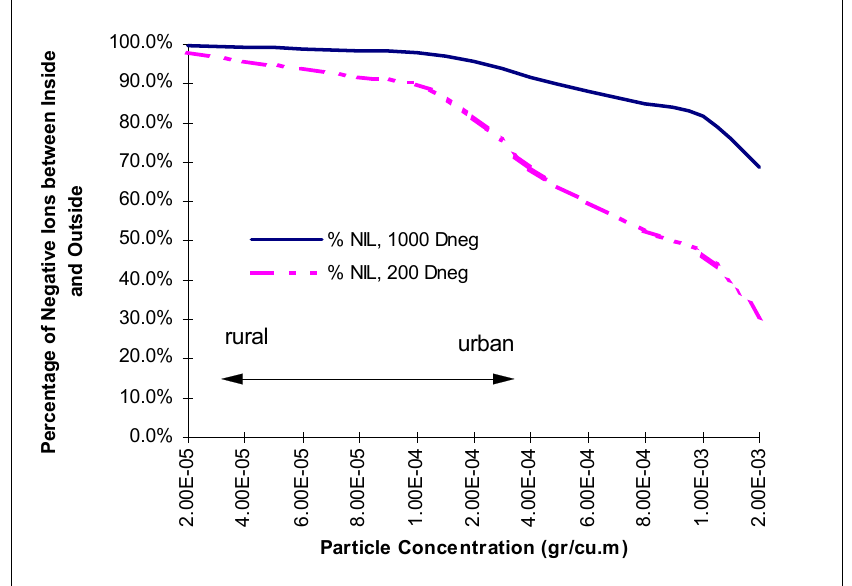
Figure 5: Relationship between %NIL and Particle